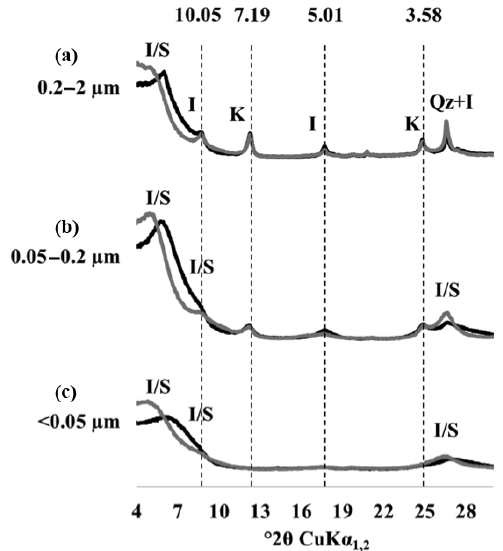
Figure 3. X-ray diffraction patterns of particle-size fractions in one of the replicated plots of the LTBF experiment sampled at the be- ginning of the BF treatment. The black line corresponds to air-dried preparations, and the grey line corresponds to glycolated prepara- tions. (a–c) From top to bottom: coarse clay fraction (0.2–2µm), medium clay fraction (0.05–0.2µm), fine clay fraction ( < 0 . 05µm). The letter labels denote the type of mineral detected: kaolinite (K), illite (I), quartz (Qz), and mixed-layer illite/smectite (I/S). Numbers above the dashed lines correspond to angströms